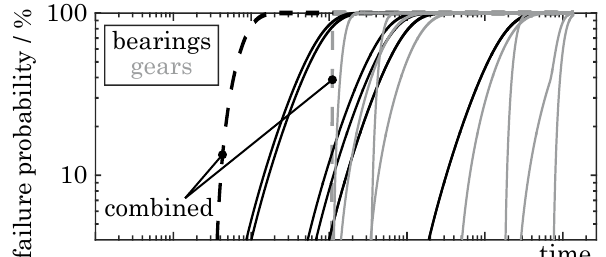
Figure 6: Failure probability of drivetrain, broken down by components,